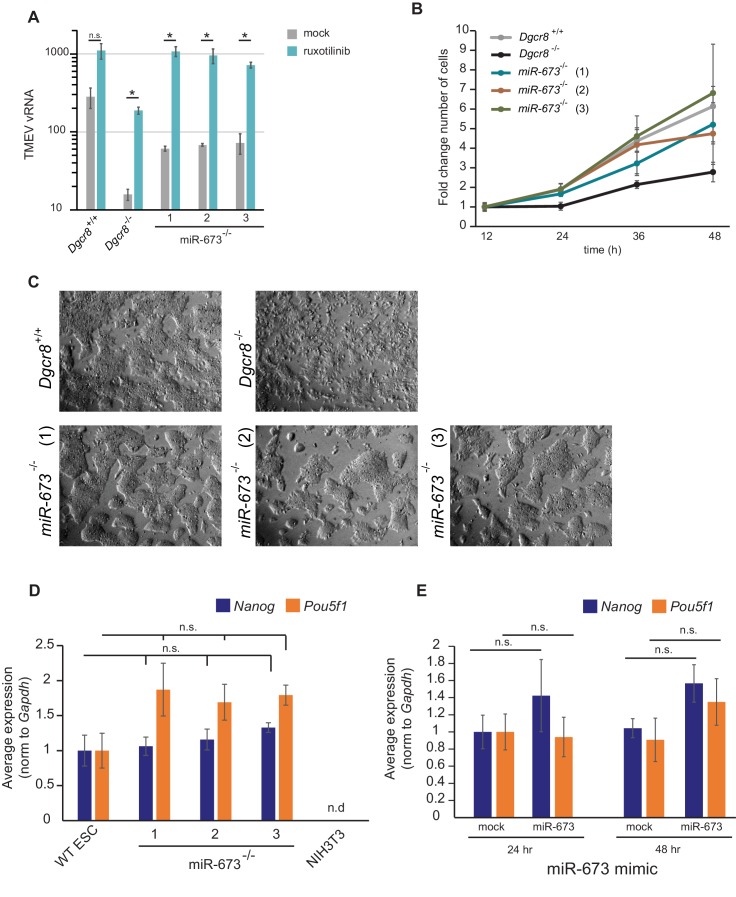
Characterization of miR-673 -/- mouse ESCs.(a) TMEV vRNA quantification in wild-type and miRNA-deficient cell lines after mock or Ruxolitinib treatment (JAK1/2 inhibitor). Data show the average (n = 3)±s.d., (*) p value < 0.05 by Student’s t-test, n.s. non-significant (b) Growth curves of ESCs. Data show the average (n = 3)±s.d. (c) No obvious morphological changes were observed between wild-type (Dgcr8+/+) and miR-673-deficient ESCs (d) Quantification of Nanog and Pouf5f1 pluripotent markers upon knocking out miR-673 by CRISPR in comparison to wild-type ESCs, data show the average (n = 3)±s.e.m, (n.s.) non-significant by t-test. NIH3T3 serves as a negative control for pluripotent maker expression (e) Quantification of Nanog and Pouf51 expression after reintroduction of miR-673 mimics and controls for 24 or 48 hr. Data show the average (n = 3)±s.e.m. (n.s.) non-significant by t-test.